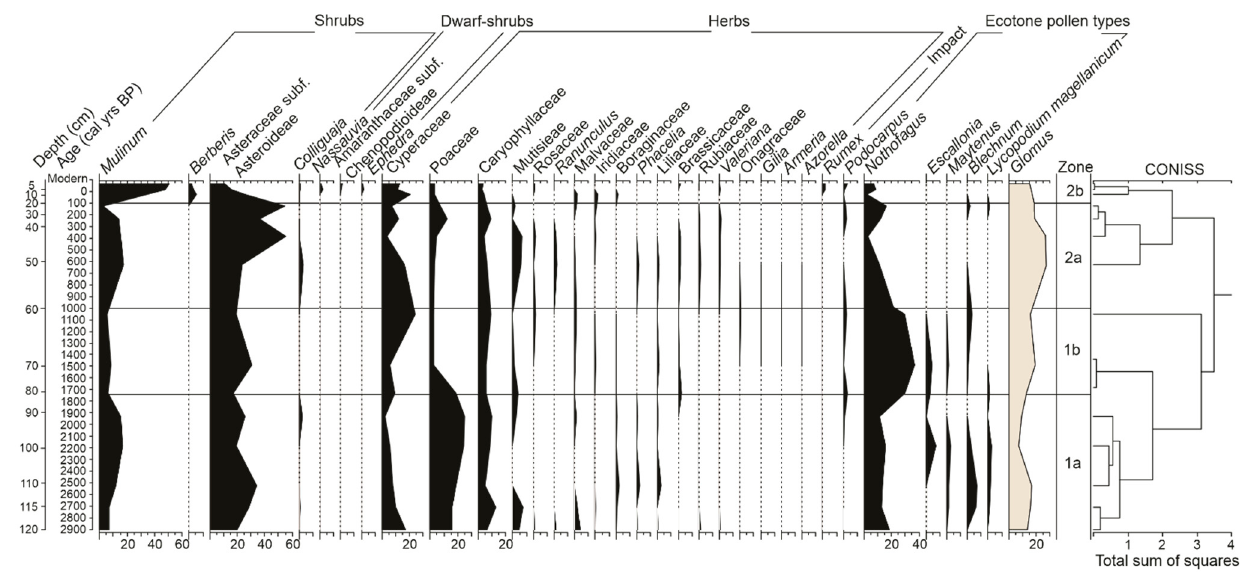
Figure 4. Pollen diagram in percentages and pollen zones of the Zorro Bayo wet meadow.